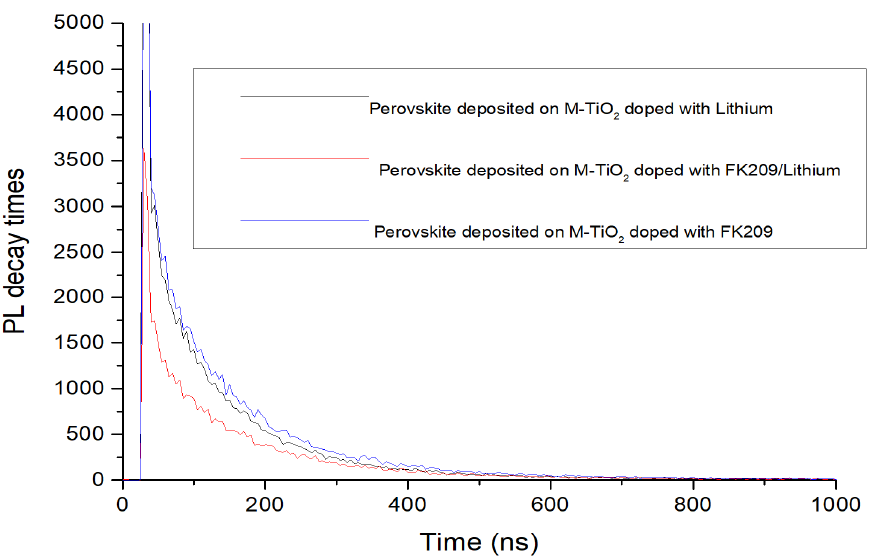
Figure 9. Photoluminescence decay time of perovskite deposited on M-TiO 2 doped with FK209, FK209/lithium and lithium and measured using fluorescence PL decay lifetime.